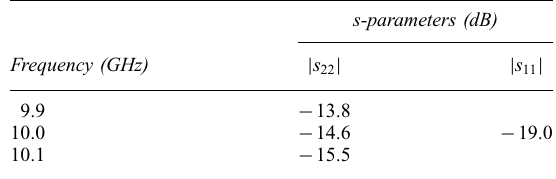
TABLE VI Reflection Coefficients at LO and RF Ports of the QPSK